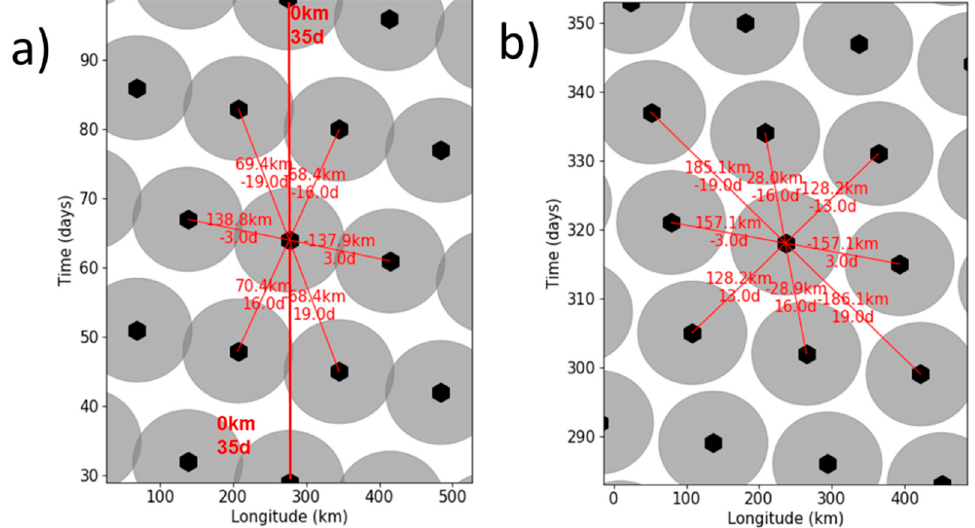
Figure 8. Same as Figure 1 for actual AltiKa data. Panel ( a ) is for the 35-day repeat phase in 2015 and panel ( b ) is December 2017 during the drifting phase.